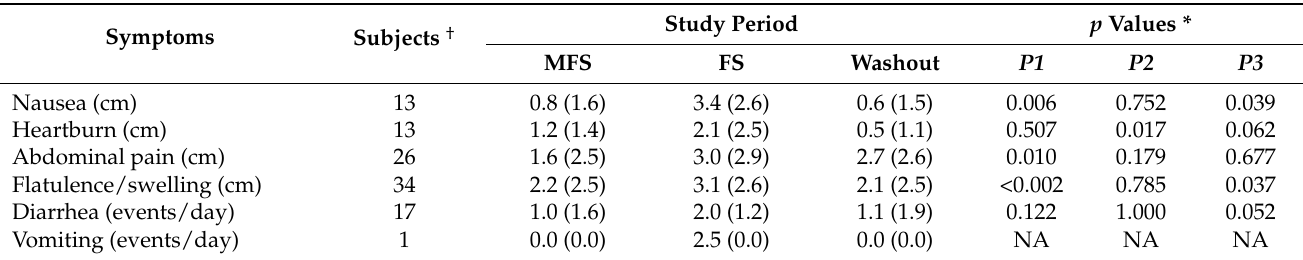
Table 5. Overall daily intensity of symptoms related to iron